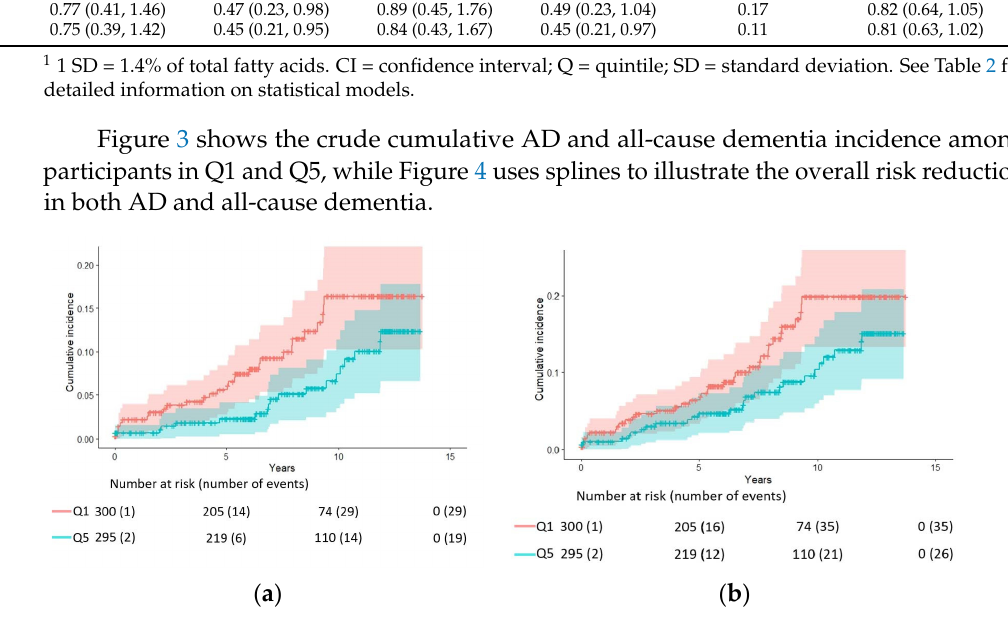
Table 3. Hazard ratios (HR) for red blood cell DHA on Alzheimer’s disease (AD) and all-cause de- mentia ( n = 1453) ignoring 37 individuals with incident Alzheimer’s or all-cause dementia within five years of baseline.